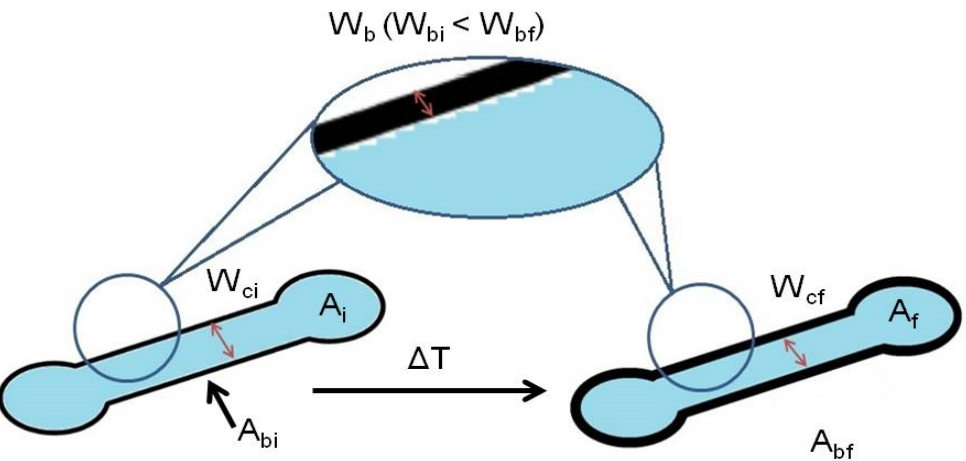
Figure 2. Scheme of a µPAD depicting the parameters before (left) and after (right) the heating step; being W ci the wax barrier before heating, A i the internal area before heating and A bi the wax barrier area before heating; and W cf the wax barrier after heating, A f the internal area after heating and A bi the wax barrier area after heating.